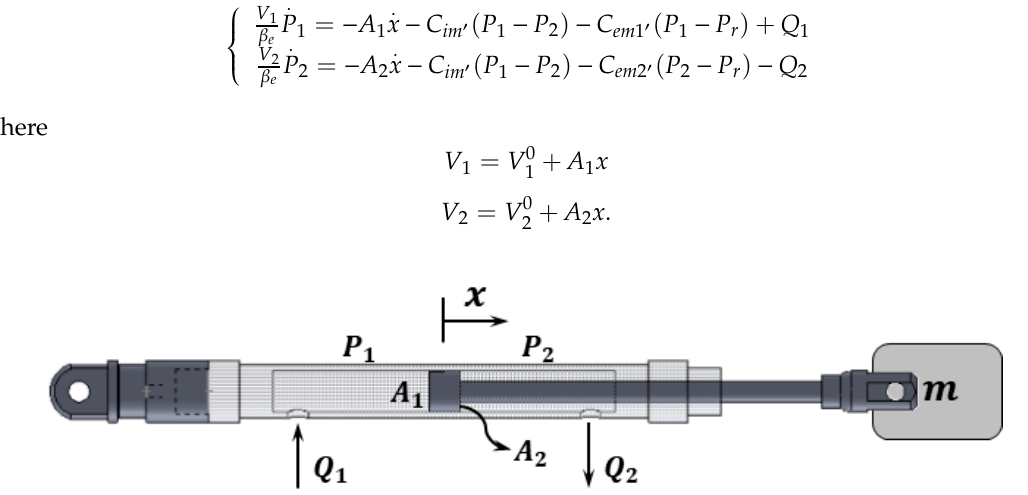
Figure 7. Structure of the hydraulic single-rod cylinder.